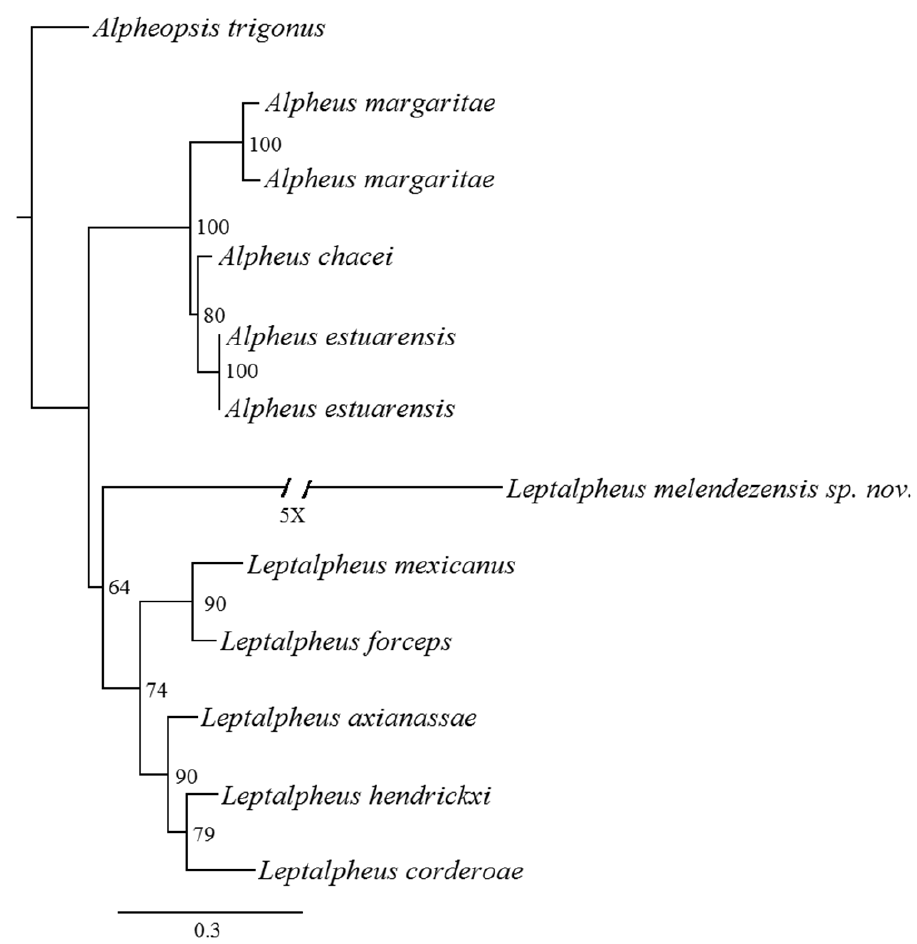
Figure 9. ML tree for Leptalpheus 16S sequences. Numbers in the nodes are 1000 bootstrap iterations result